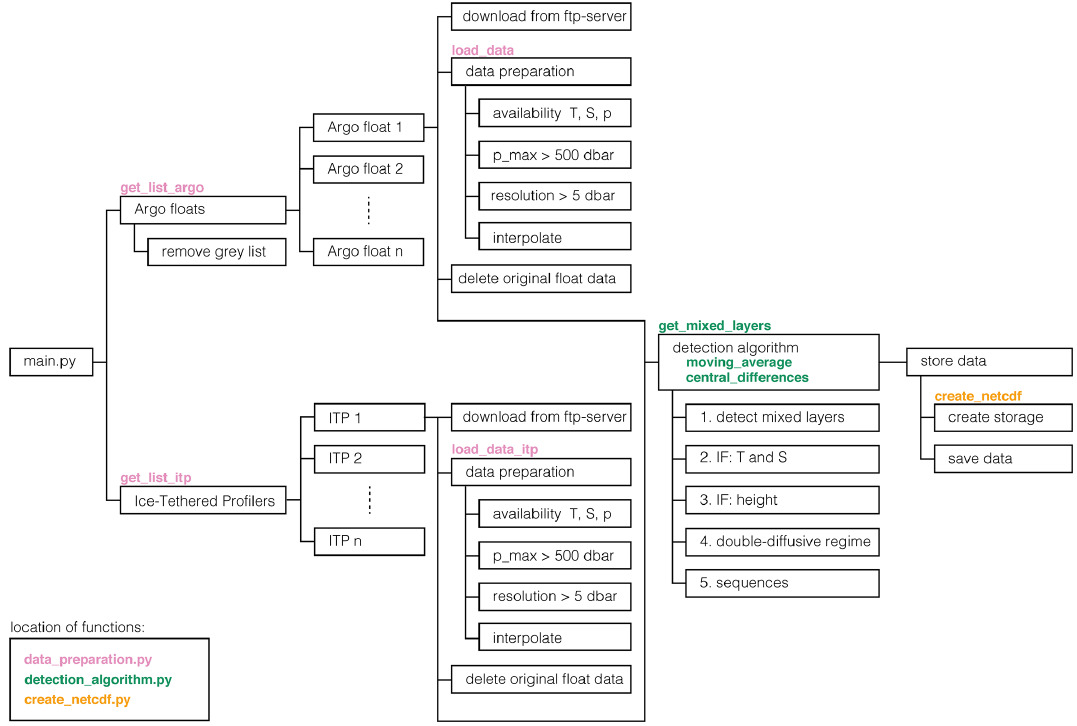
Figure A4. Structure of the software. Each step in the software is shown by a box. Whenever a particular step is contained inside a function, the name of the function is mentioned above the step. Details of the preprocessing of the data and the detection algorithm are discussed in Sects. 2 and 3, respectively.